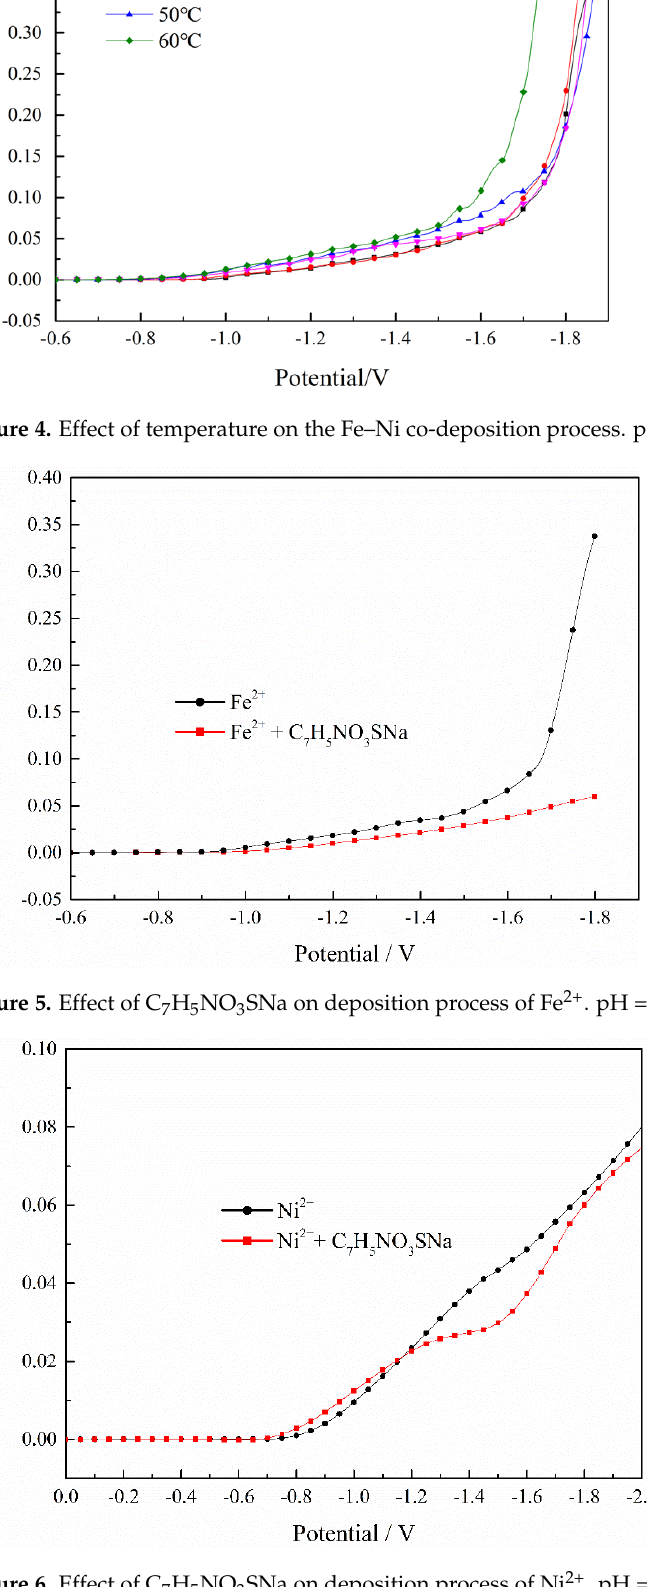
Figure 6. Effect of C 7 H 5 NO 3 SNa on deposition process of Ni 2+ . pH = 2, T = 30 °C.